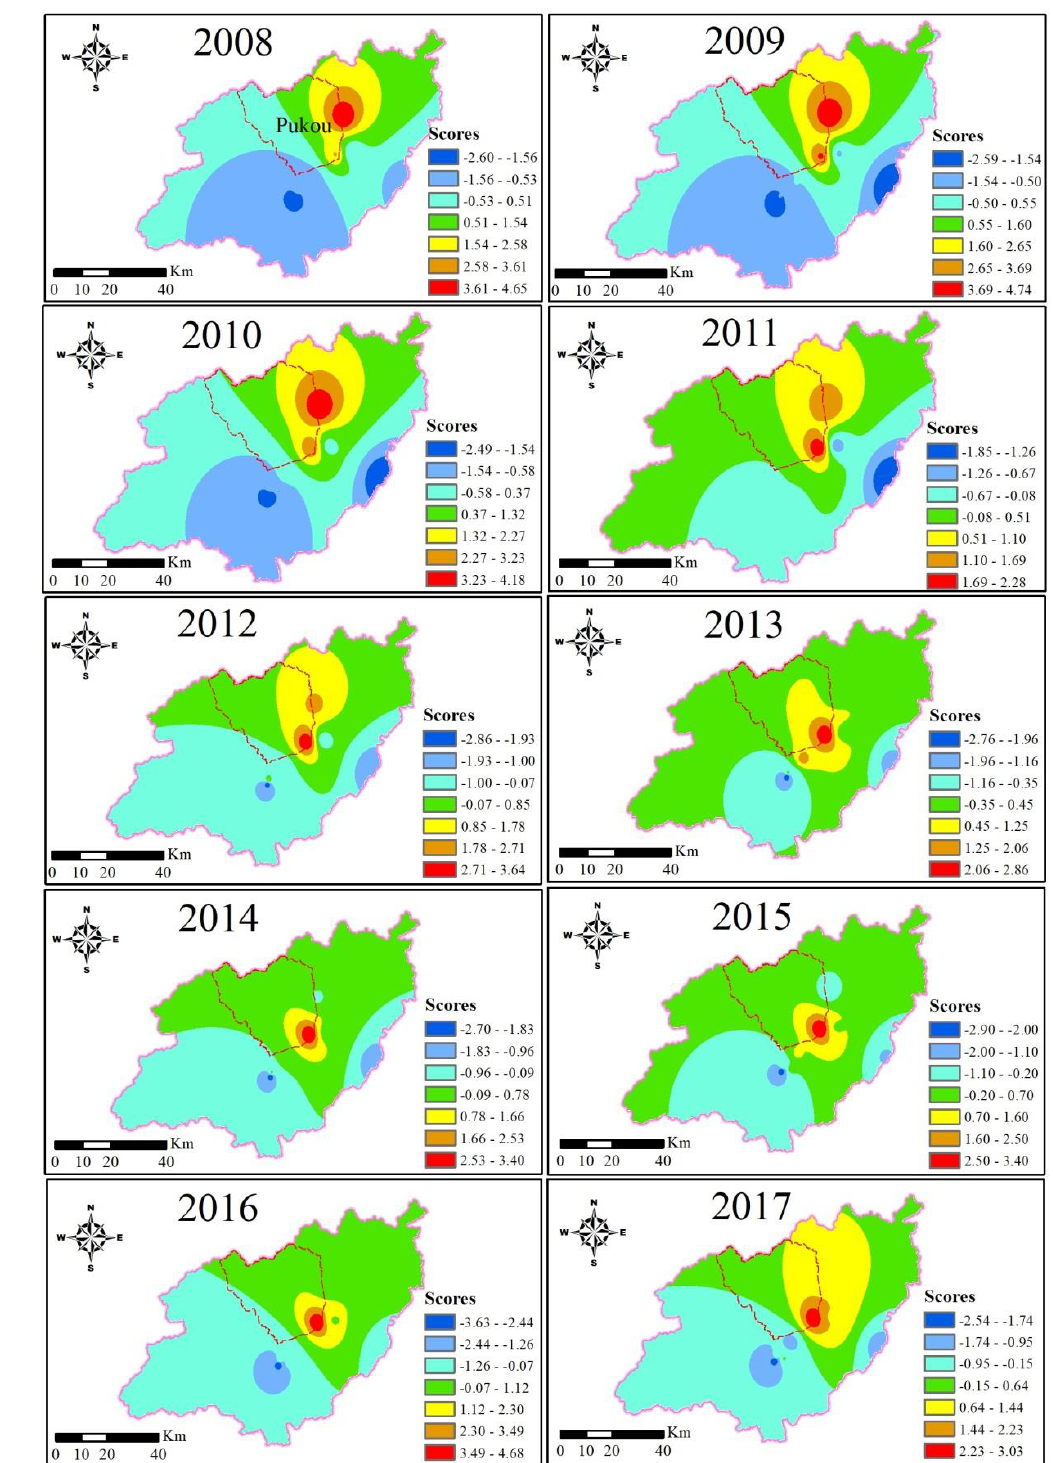
Figure 4. Spatial and temporal distribution of water quality in Xin’anjiang River.